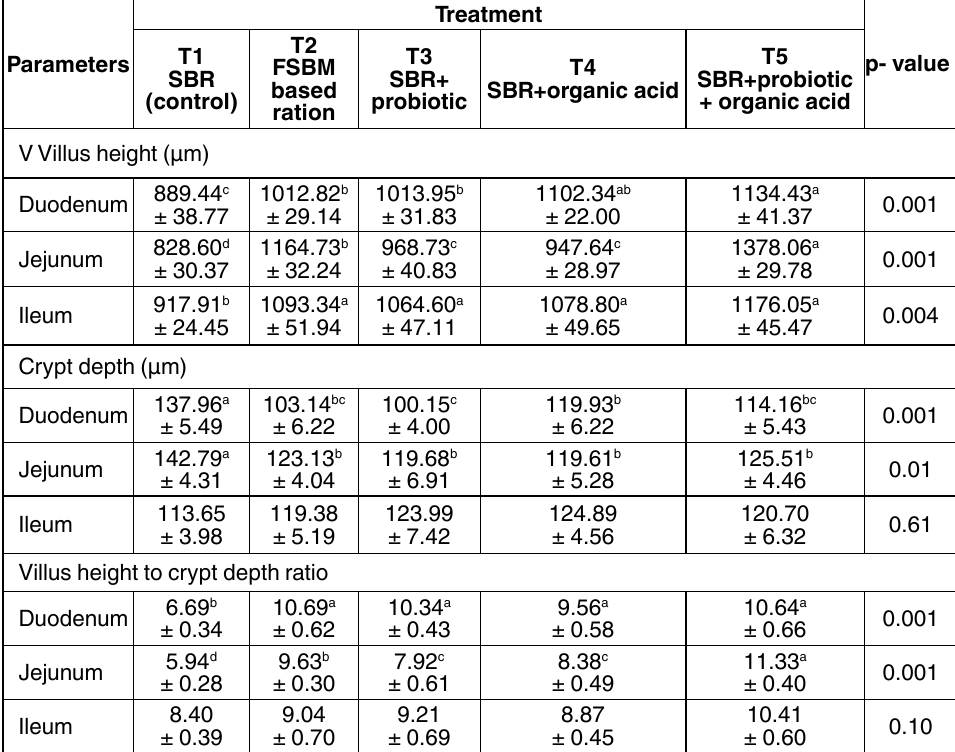
Table 3. Effect of dietary treatments on intestinal morphology of broilers at six weeks of age